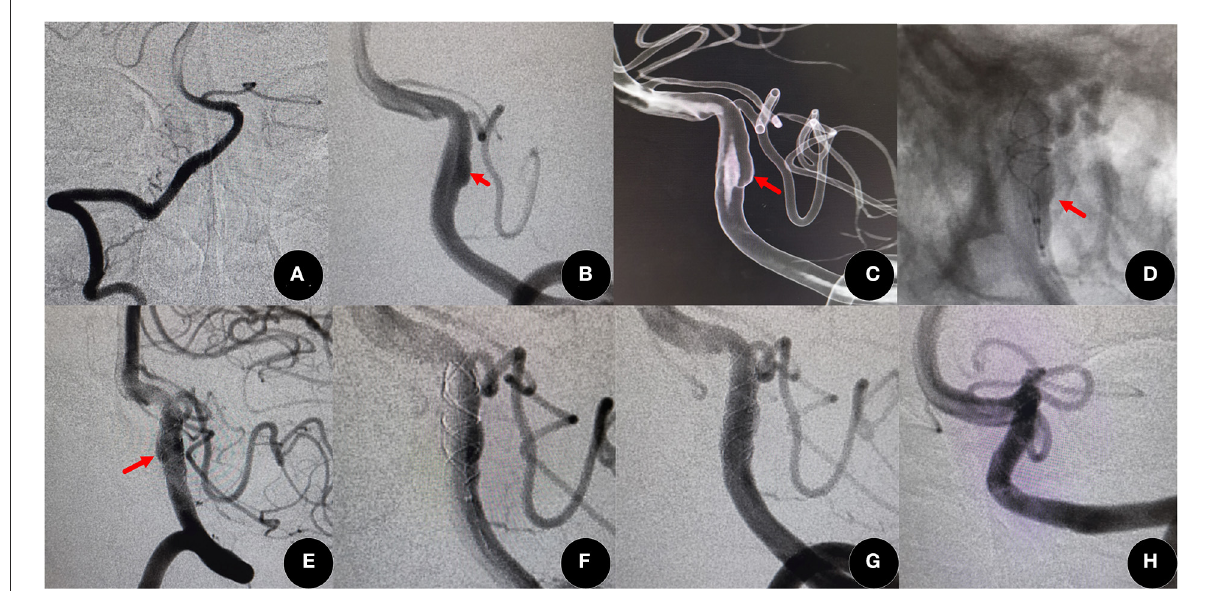
FIGURE1 On routine examination, a fusiform aneurysm was found (60-year-old women). (A) Normal right vertebral artery. (B,C) Angiographic images showed a left fusiform vertebral artery (red arrow) (D,E) A Leo plus stent (3.5mm × 25mm) was deployed by telescopic technique (red arrow), and the aneurysm incomplete occlusion [O’Kelly Marotta (OKM) grade B]. (F,G) After the deployment of another Leo plus stent of the same size, flow into the aneurysm was obviously decreased and the degree of occlusion improved to good occlusion (OKM grade C). (H) The